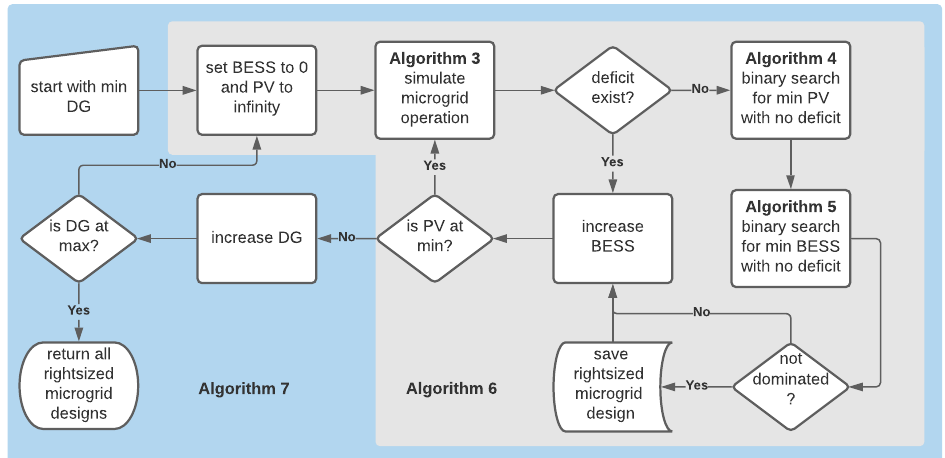
Figure 2. This flowchart illustrates the rightsizing procedure, with DG denoting diesel generator power and PV denoting photovoltaic power. The energy management system (Algorithm 1) is run exclusively as a subroutine of single time step simulation (Algorithm 2), which is run exclusively as a subroutine of the microgrid simulation (Algorithm 3). Microgrid simulation (Algorithm 3) is run as a subroutine within the binary search for the minimum photovoltaic power (Algorithm 4), within the binary search for the minimum BESS energy (Algorithm 5), and within the rightsizing search for a given level of diesel generation (Algorithm